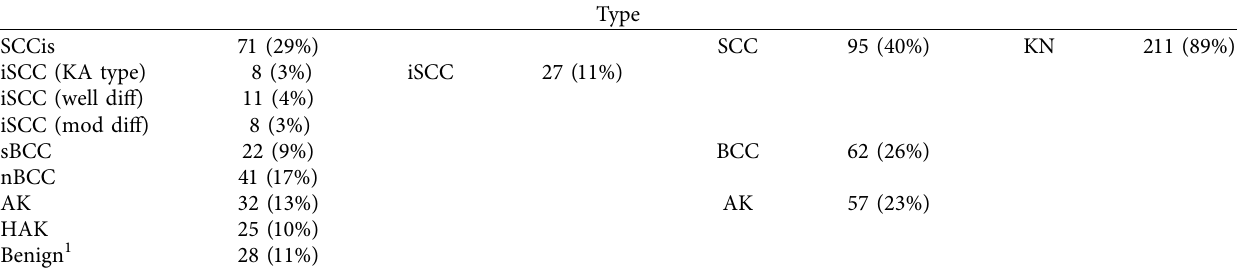
Table 2: Histopathological diagnoses of 244 lesions among 63 patients.